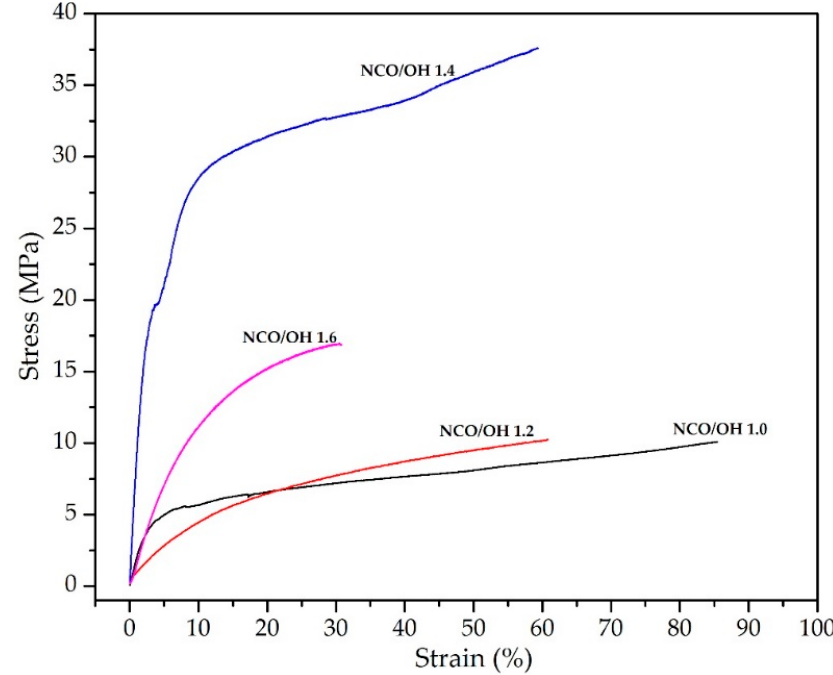
Figure 6. Stress-strain curves of PU-DOD with different NCO/OH ratios.